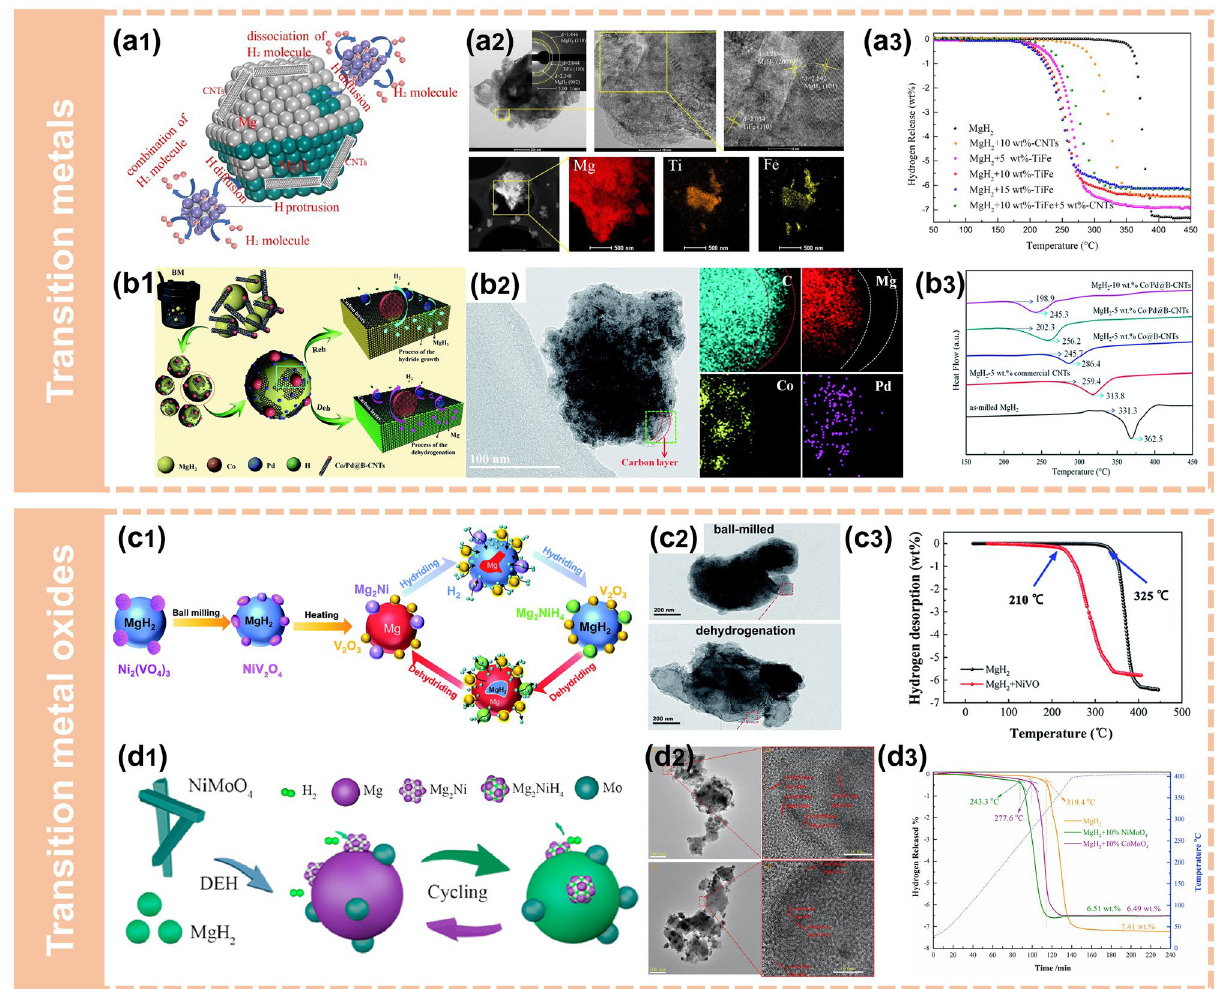
Fig. 6 Synthesis of nanostructured Mg-based composites via mechanical milling. a1 Schematic summary of the catalytic mechanism for the TiFe and CNTs catalyzed MgH 2 particles. a2 TEM images with corresponding SAED pattern and EDS mappings of the MgH 2 + 10 wt%-TiFe composite. a3 Non-isothermal desorption curves of different samples. Reproduced with permission from Ref. [84]. Copyright 2021 Elsevier; b1 A schematic illustration of the "bidirectional catalysis" mechanism of Co/Pd@B-CNTs during the dehydrogenation and hydrogenation of MgH 2